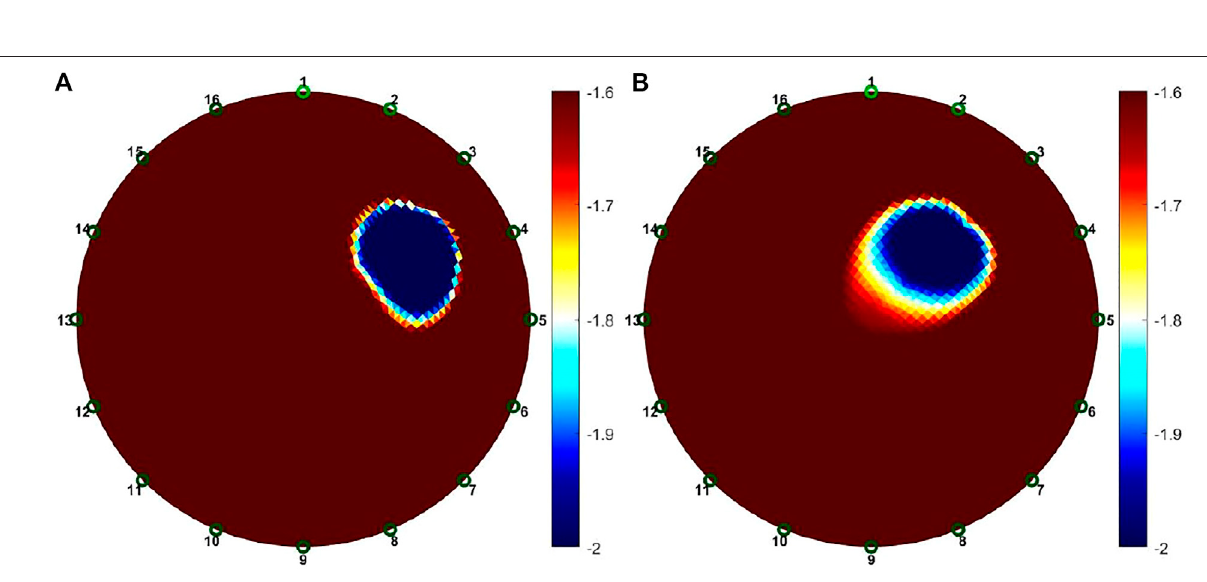
Frontiers in Electronics |